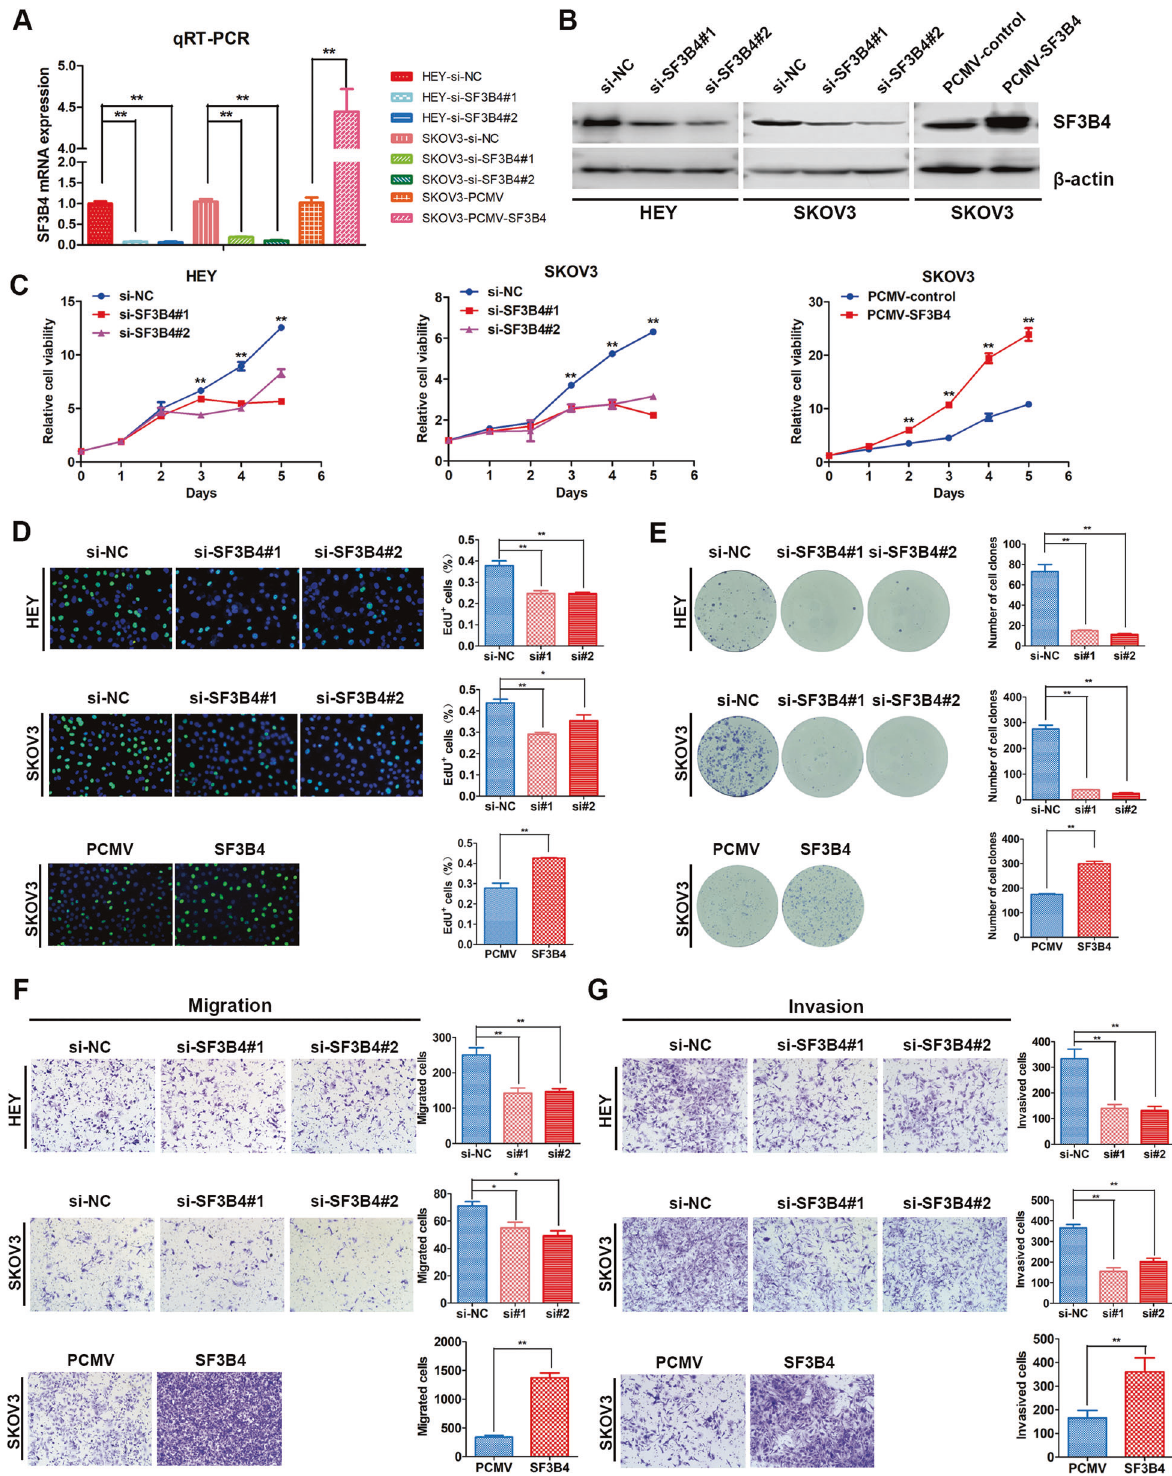
Fig. 2 SF3B4 promotes proliferation, migration and invasion of ovarian cancer cells. A , B SF3B4 knockdown and overexpression ef fi ciency was con fi rmed by qRT-PCR ( n = 3 biologically independent samples) and western blotting. C Growth curve showed the growth of ovarian cancer cells upon SF3B4 knockdown and overexpression ( n = 3 biologically independent samples). D EdU assay showed the proliferation ability of ovarian cancer cells after SF3B4 knockdown and overexpression ( n = 3 biologically independent samples). E The effect of SF3B4 on colony formation in ovarian cancer cells ( n = 3 biologically independent samples). F , G In HEY and SKOV3 cells, up and downregulation of SF3B4 affected migration and invasion capacity ( n = 3 biologically independent samples). P -value was obtained by Unpaired t -test. Results represent the mean ± SD of three independent experiments. * P < 0.05, ** P < 0.01.